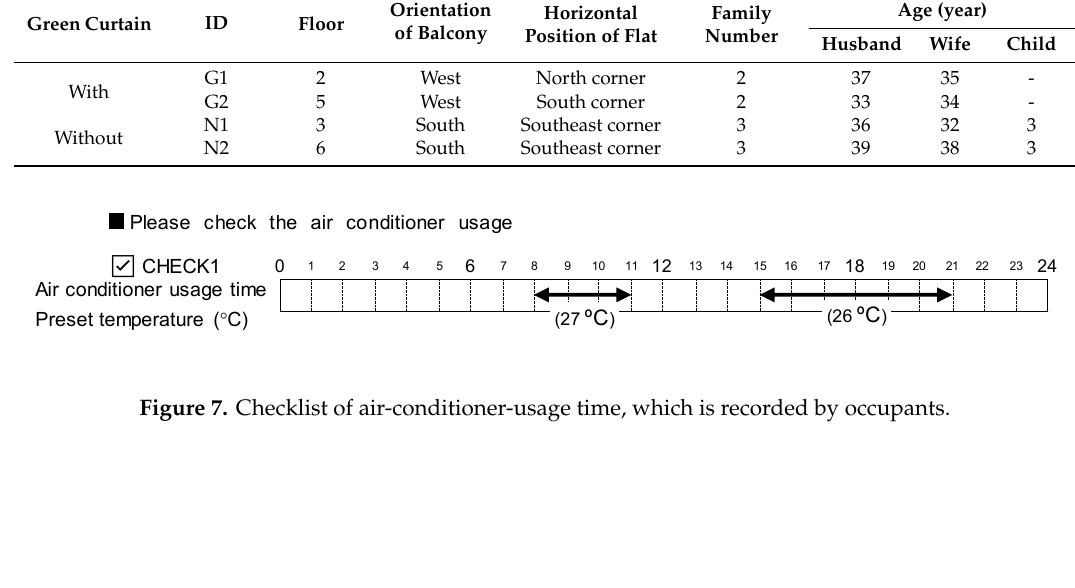
Figure 7. Checklist of air-conditioner-usage time, which is recorded by occupants.